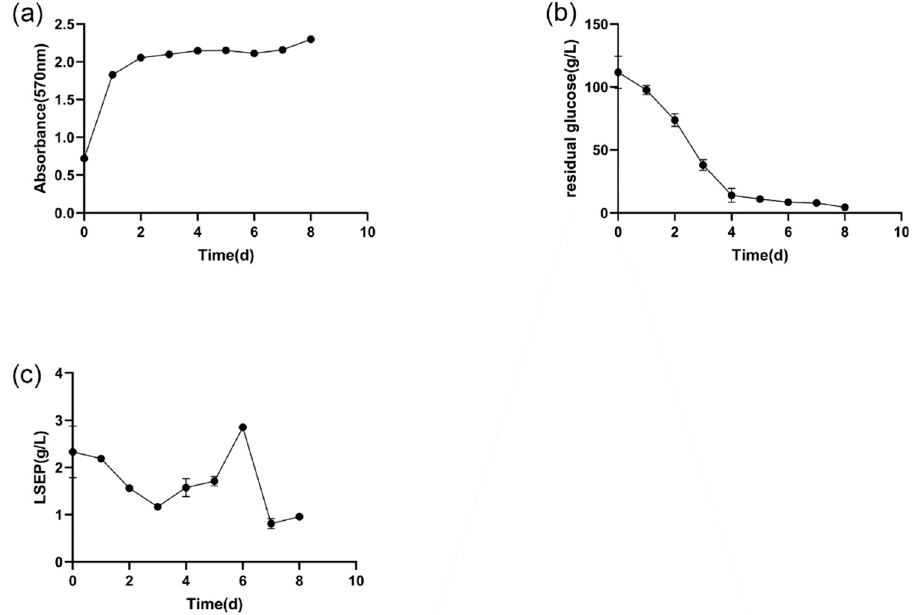
Figure 1. The process of fermentation: the growth of L. starkeyi ( a ), the consumption of glucose ( b ), the production of LSEP ( c ).